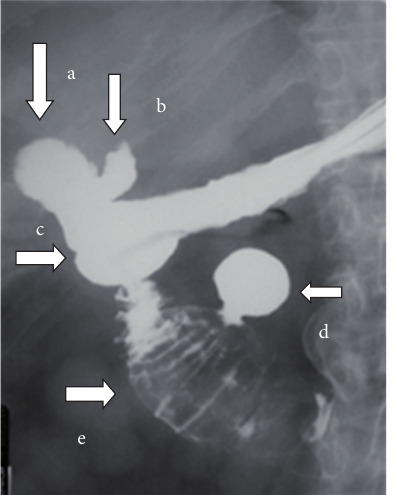
Figure 6: Five minutes after intake of the oral contrast all the anatomic elements are well visualised: (a) the gallbladder filled with contrast, (b) the cystic duct filled with contrast, (c) the cholecystoduodenal fistula, (d) a duodenal diverticulum of the 3rd part filled with contrast, and (e) a large gallstone impacted on the 2nd to 3rd part of the duodenum.